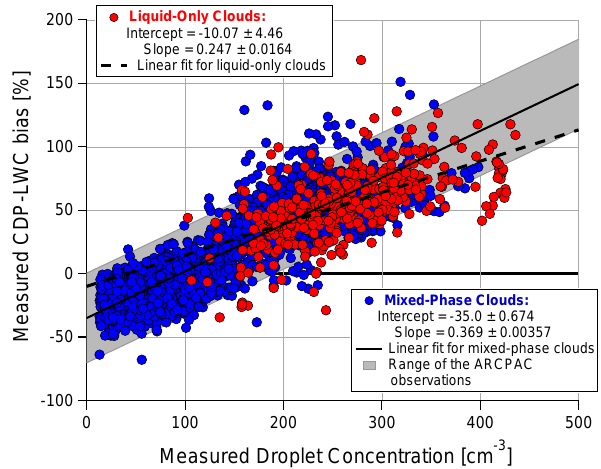
Fig. 7. CDP-LWC bias (Eq. 4) for 1Hz measurements in liquid-only clouds on transit flight from Tampa to Denver on 29 March 2008 and in mixed-phase clouds on six ARCPAC flights (11, 12, 15, 18, 19 and 21 April 2008). Grey shaded region shows one standard deviation of the mixed-phase cloud